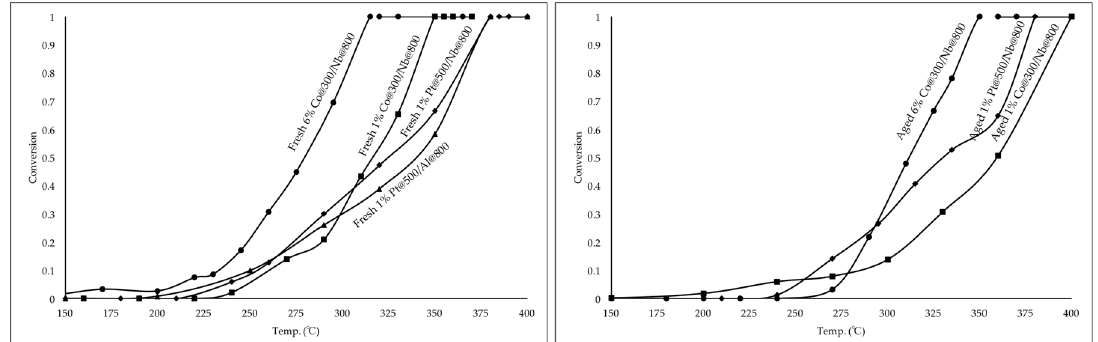
7 of 12 Figure 6. Fresh and aged 6% Co@300/Nb@800 and 6% Co@300/Al@800 for propane oxidation with moisture. Aging test was conducted at 400°C with reaction gases for 12 h. Gas composition with H 2 O 5 vol %, C 3 H 8 0.1 vol %, O 2 17.85 vol %, N 2 77.05 vol %. Catalysis volume: 0.1 mL, GHSV: 64,800 (h − 1 ). This figure also demonstrates the obvious advantage of 6% Co@300/Nb@800 over 6% Co@300/Al@800 when both catalysts were aged for 12 h in feed gas containing H 2 O at 5 vol %. The aged 6% Co@300/Al@800 lost the majority of its active sites achieving only about 40% (0.4) conversion at 400°C. Aged 6% Co@300/Nb@800 showed significant catalytic activity even after being aged in steam containing reaction gas at 400 °C for 12 h. 2.4. Comparison of Co 3 O 4 and Pt for Propane Oxidation The state of the art catalyst used in VOC abatement is typically 1% Pt/Al 2 O 3 . For the purpose of a practical application, the behavior of 1% Co@300/Nb@800 and 6% Co@300/Nb@800 was compared with 1% Pt/Nb@800 and 1% Pt/Al@800 for propane oxidation. The result shown in Figure 7 (left) indicates that 6% Co@300/Nb@800 shows a performance advantage over 1% Pt@500/Nb@800 and 1% Pt@500/Al@800. Some advantage for 1% Co@300/Nb@800 is noted at both low and higher conversions however, diffusional effects may be operative. 1% Pt@500/Nb@800 shows no advantage over 1%